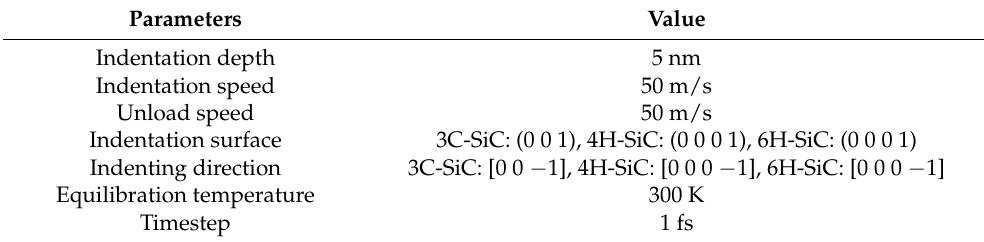
Figure 2. Motion parameter of diamond indenter. Table 2. Main parameters of indenting.